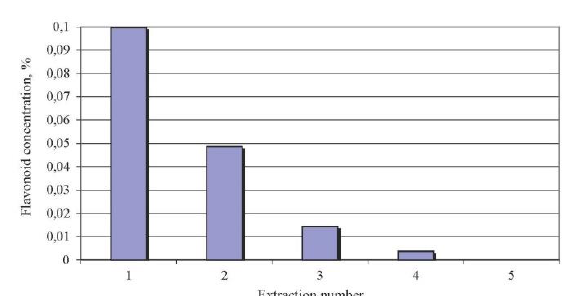
Fig. 8. Determination of the optimal extraction multiplic-